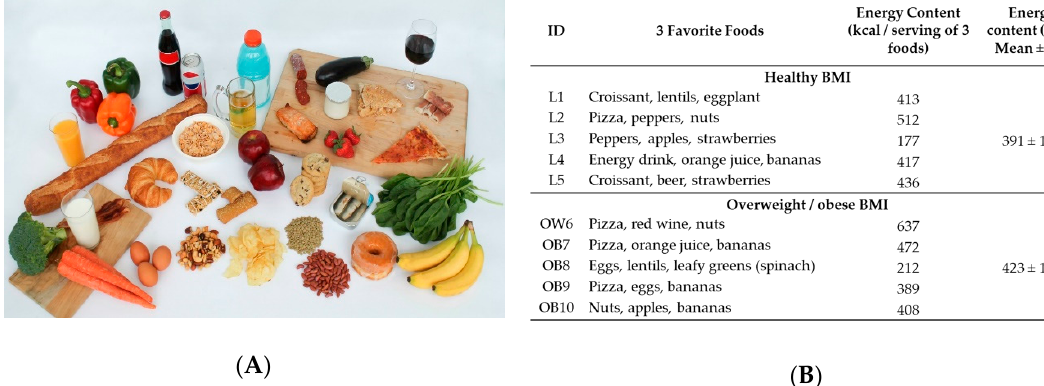
Figure 1. Ice breaker interview exercise. ( A ) Key informant interview participants were asked to identify their three favorite foods from this photograph. Included foods were selected to illustrate a broad range of foods from healthy to unhealthy based on their positive or negative association with risk of obesity and co-morbidities. ( B ) Favorite foods selected by participants, and individual and mean energy content per selection. SD, standard deviation. Source for calorie content: https://fdc.nal.usda.gov/.